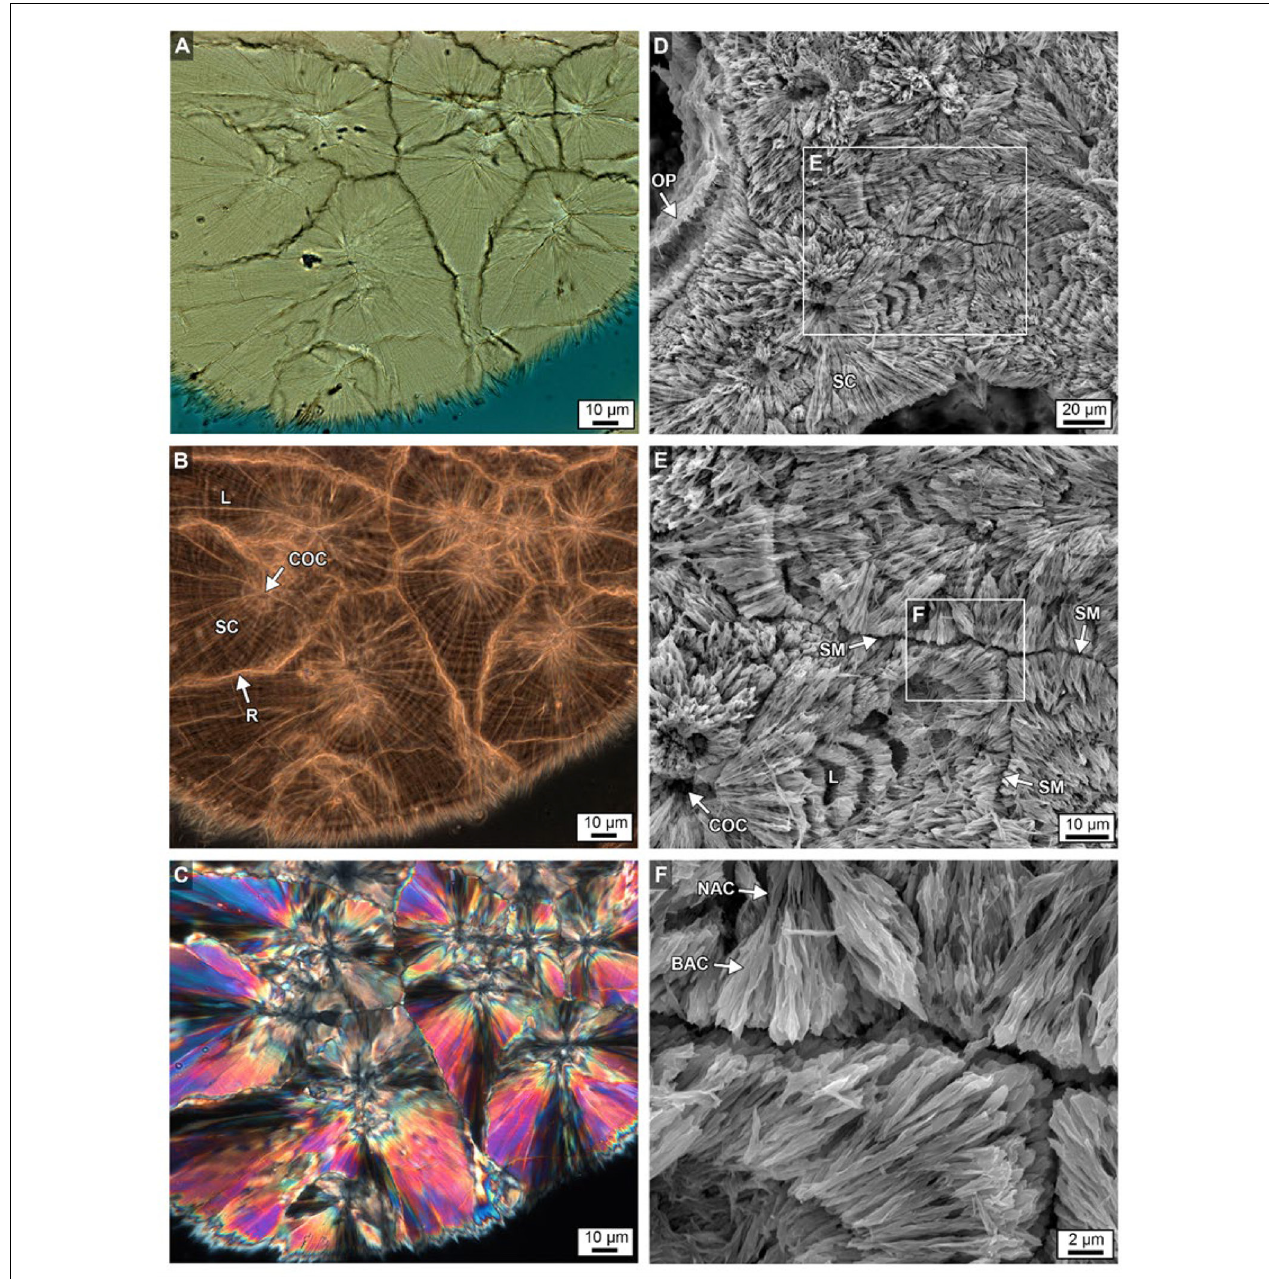
FIGURE 11 | Brightfield (BF; A ), RAC (B) , and polarization (POL; C ) images of a skeletal wall showing the crystalline growth history of multiple types of sclerodermite (SC) layering from several centers of calcification (COCs) from the bottom 6 cm of Core 3. Details are presented in Figures 9B,C . (D–F) Complementary images of etched intact skeleton showing similar SC margins, narrow aragonite crystals (NAC) and broad aragonite crystals (BAC) and COCs at increasing levels magnification, with ensuing enlargements from each white box.